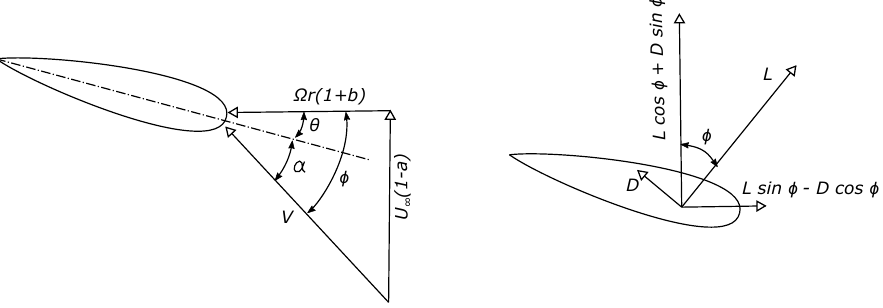
Figure 2. Velocity vector and forces acting on the blade